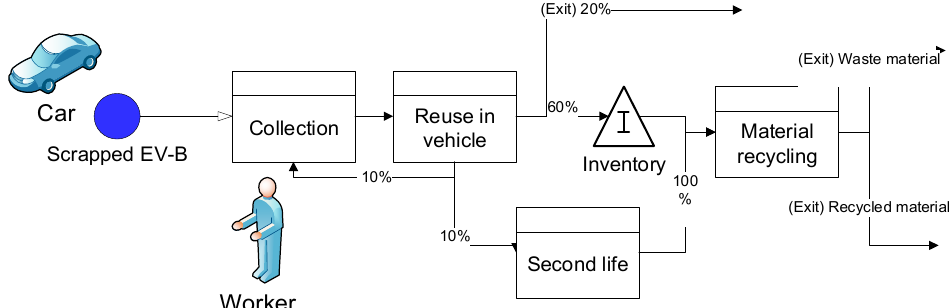
Figure 6. Example of a simple discrete event simulation model of collector capacity for different rates of reuse, recycling and second life.